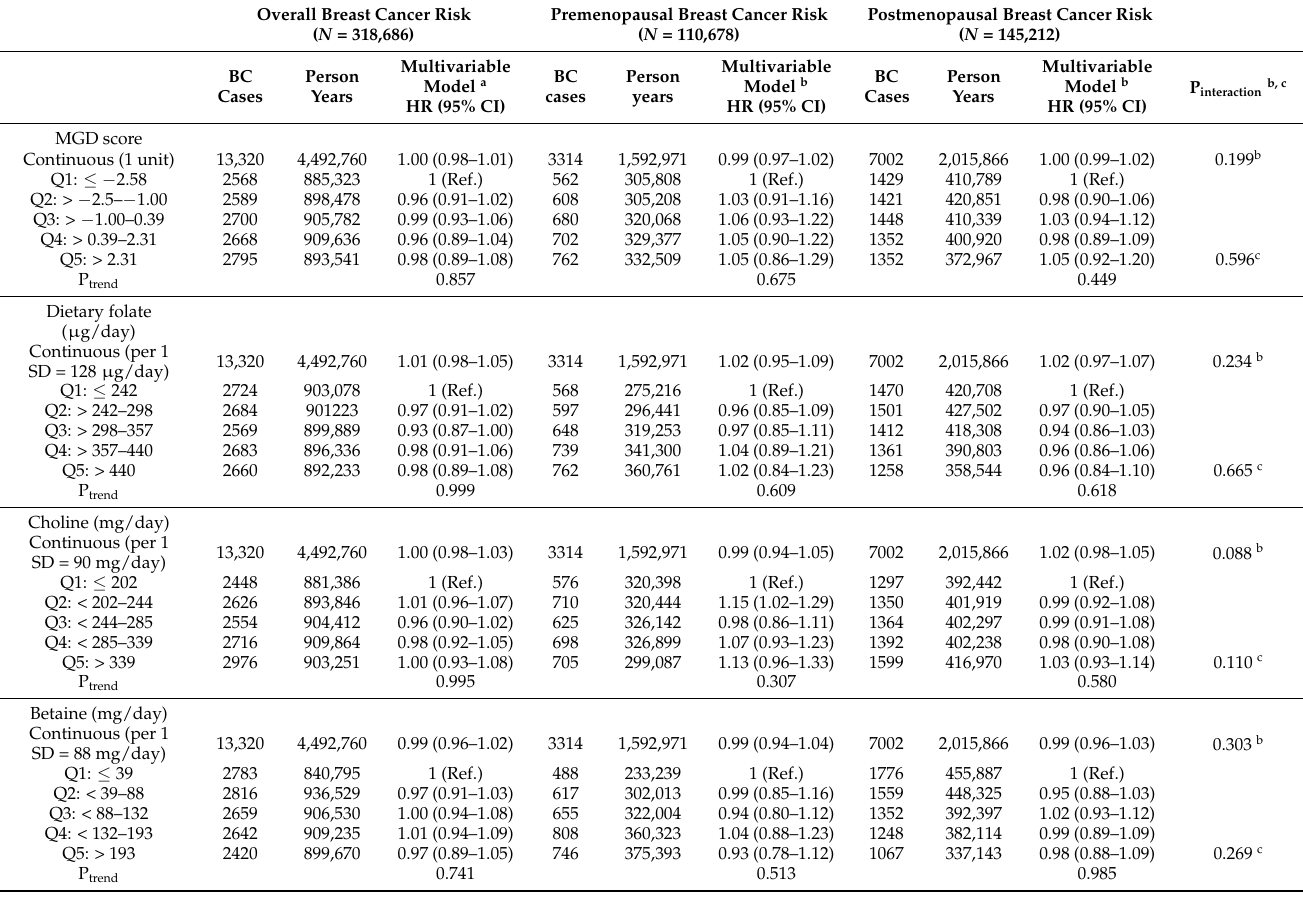
Table 2. Hazard ratios (HRs) and 95% confidence intervals (CIs) for breast cancer (BC) by daily dietary intake of methyl- group donors (MGDs) in 318,686 women in the EPIC cohort and by pre- and postmenopausal status. Overall Breast Cancer Risk ( N =